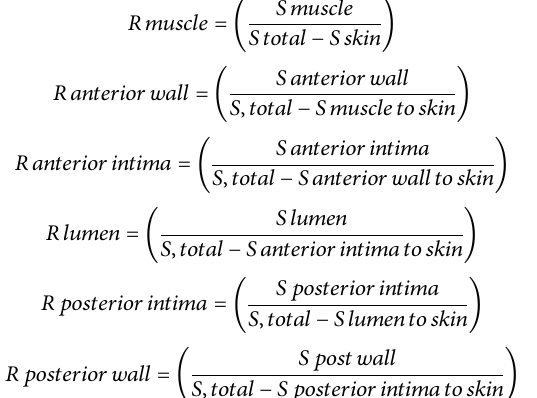
FIGURE 2 (A) Coef fi cient of signal return of the sternocleidomastoid muscle (Musc 100), carotid artery walls (anterior = AW, posterior = PW),carotid arteryintima layers (anterior= INTaw, posterior=INT pw), and lumen, pre and after four days in dry immersion (Mean ± SD - (*) p < 0.05; n=9) and (B) after six months in space (6mISS).(Mean±SD-(*) p < 0.05;n=8).(reprintedwithpermission from Ultrasound Med